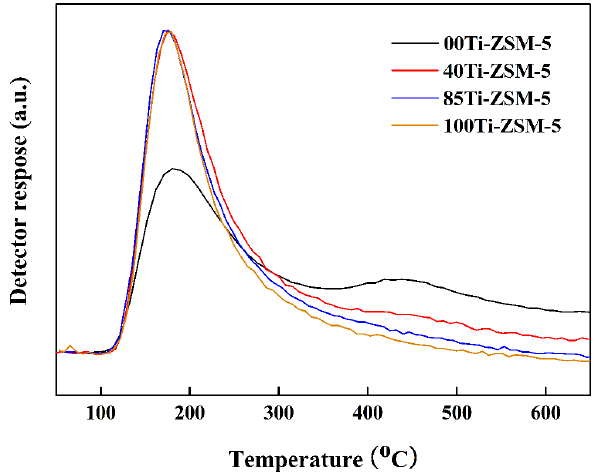
Figure 3. NH 3 -TPD patterns of hierarchical porous Ti-ZSM-5.